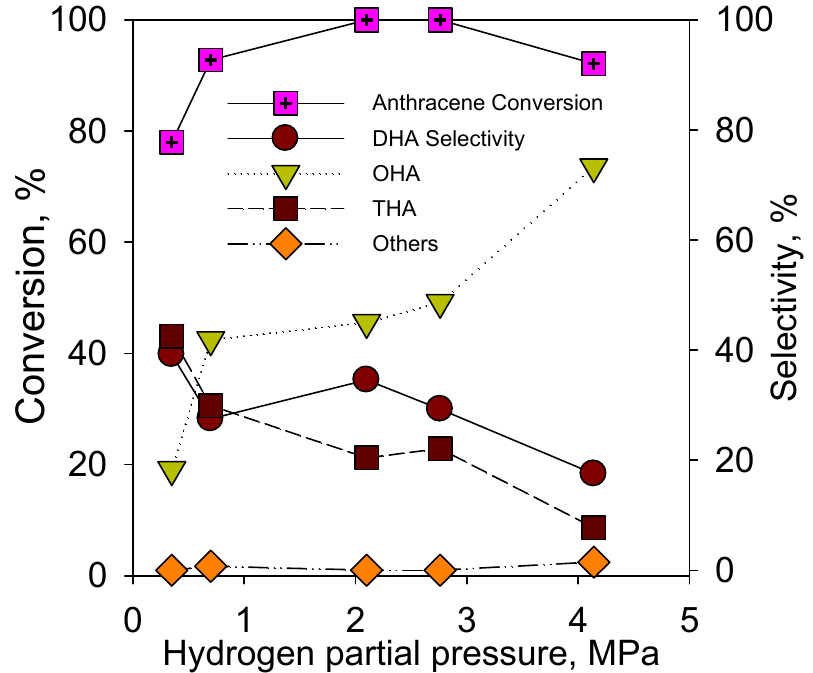
Figure 6. Effect of hydrogen partial pressure on hydrogenation of anthracene over 40% Ni/H β -zeolite catalyst. Catalyst weight: 0.5 g; Reaction temperature: 100 °C; Reaction pressure: 6.9 MPa; volume of the reactor: 50 mL; reaction time: 6 h.